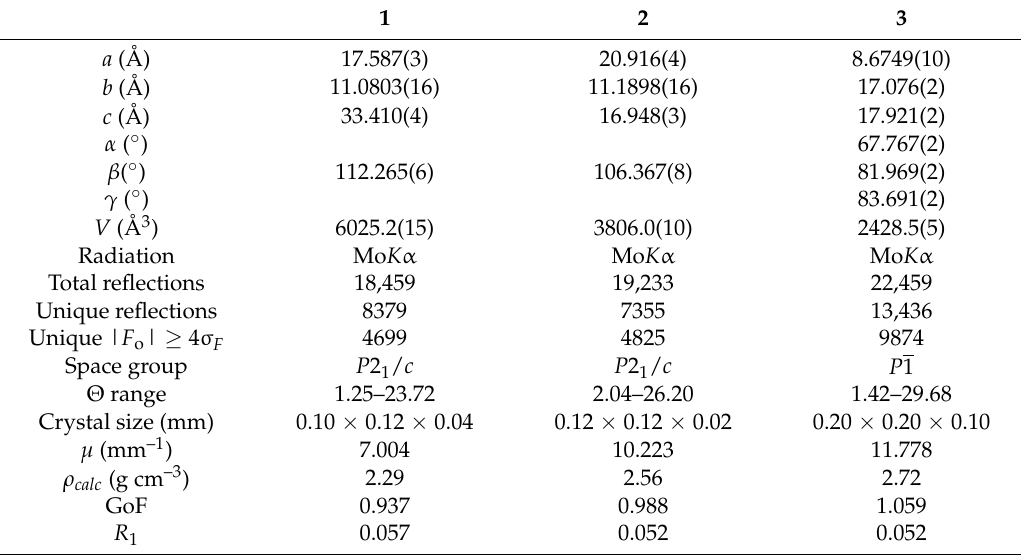
Table 1. Crystallographic data and refinement parameters for 1 – 3